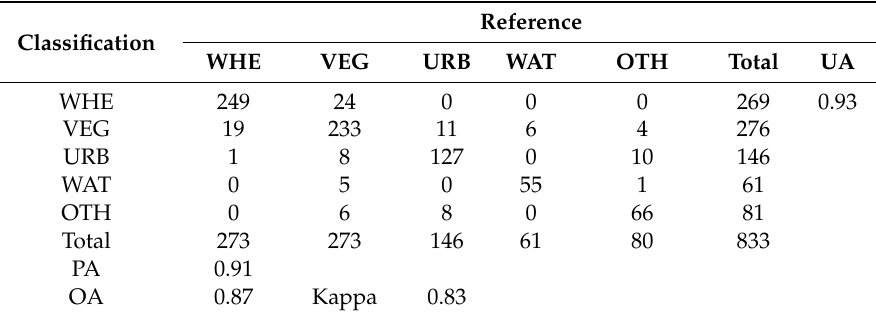
Table 5. The error matrix of